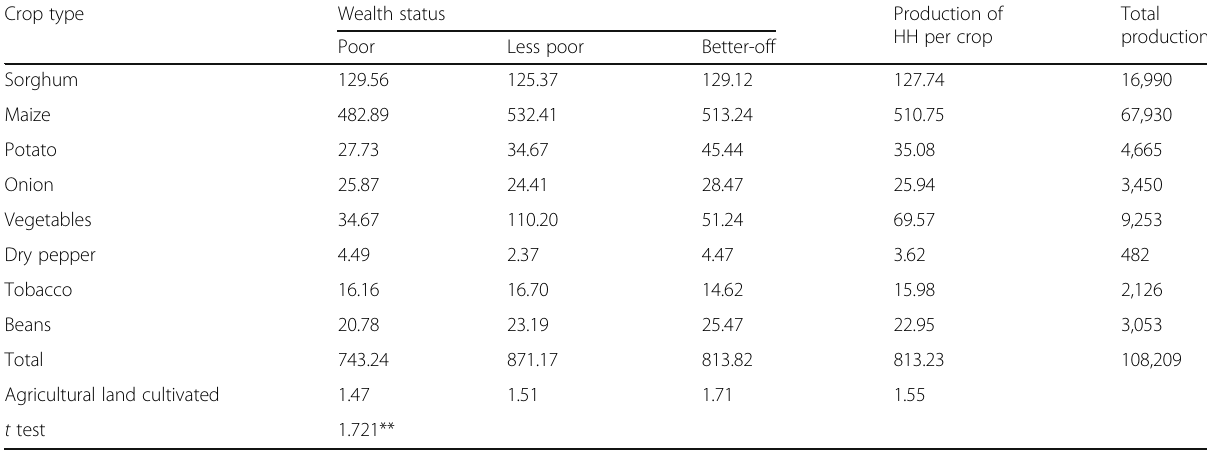
Table 3 Crop production of households by wealth group in kilogramme ( N = 133) Crop type